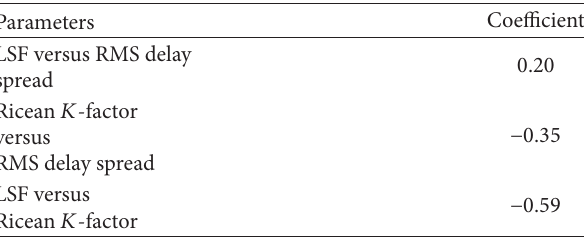
Table 5: Cross correlation coefficients.